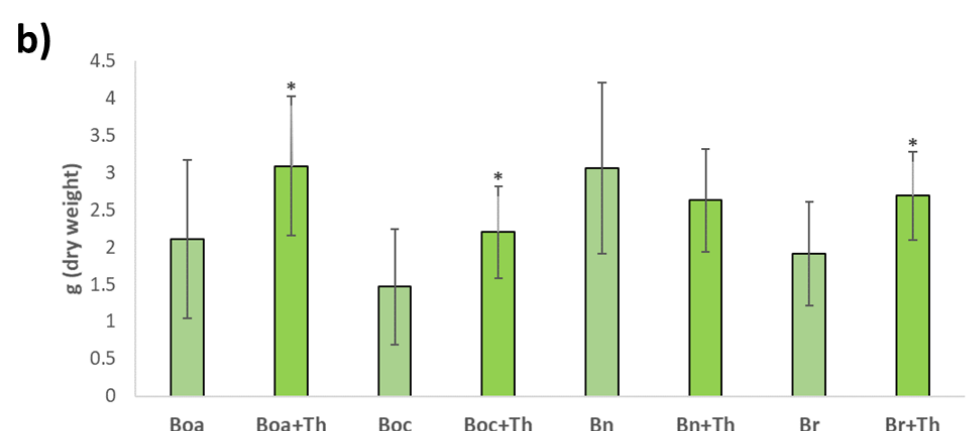
Figure 1. Mean of fresh ( a ) and dry weight ( b ) of kale (Boa), cabbage (Boc), leafy rape (Bn) and leafy turnip (Br) grown in greenhouse conditions. Plants without inoculation and inoculated with T. hamatum (+Th) were collected at 8 weeks old and measured their fresh and dry weight of the aerial part. Data are the mean of 10 plants for each crop and condition with the corresponding standard deviation. Student’s t -test was performed between uninoculated and Trichoderma -inoculated plants. Asterisks denote significant differences at p ≤ 0.05 (*).